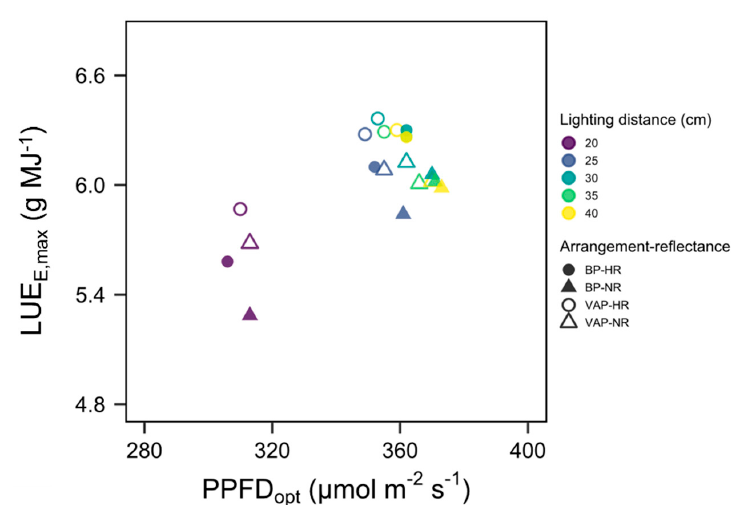
Figure 11. Optimal photosynthetic photon flux density (PPFD) setup (PPFD opt ) for achieving the maximal light use e ffi ciency (LUE E,max ) for di ff erent light arrangements, lighting distances, and floor reflectances. Light sources were arranged vertically above the plant (VAP) or between the plants (BP). Floor surface was set at non-reflective (NR) or highly-reflective (HR) material.